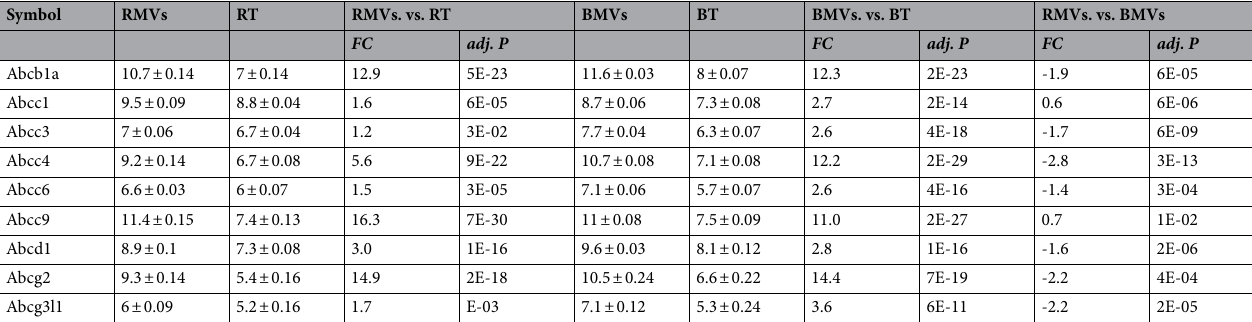
Table 4. List of ATP binding cassette transporter genes differentially expressed in rat retina and/or brain microvessels vs. retina and brain tissue samples. Results are mean ± SEM of log 2 transformed microarray